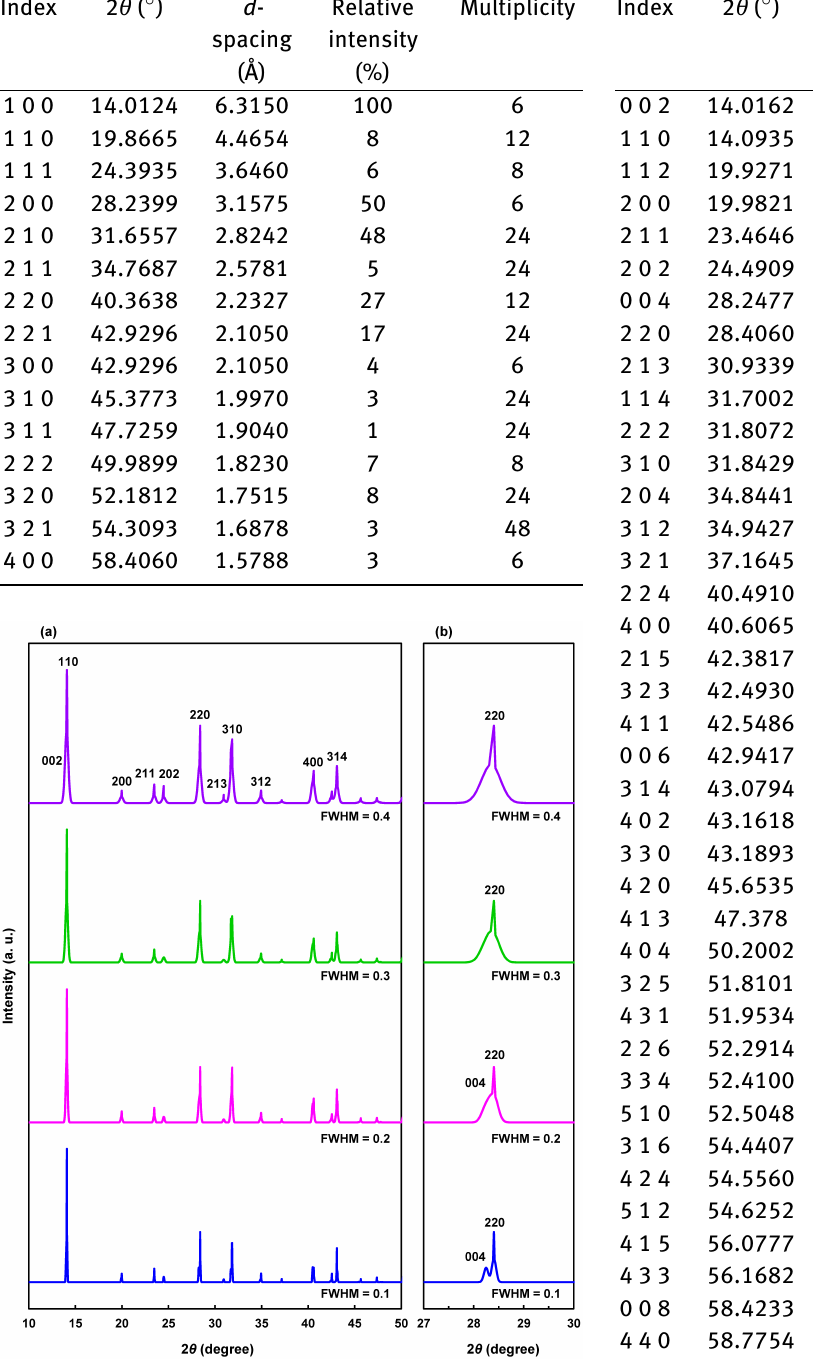
Table 6: Calculated X-ray diffraction parameters of cubic CH 3 NH 3 PbI 3 . Equivalent indices were combined. For space group Pm 3 m (221), a = 6.315(3) Å at 350 K.